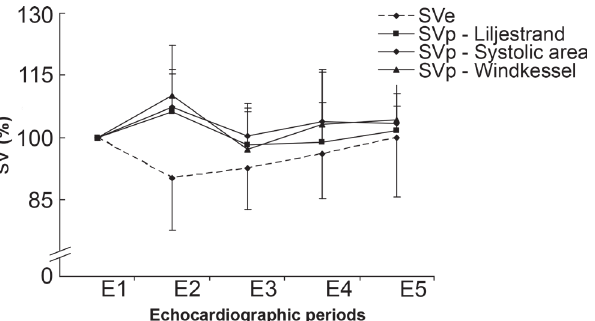
Fig 3. Stroke volume (SV) computed from echocardiographic and finger arterial blood pressure recordings (SVe and SVp respectively), at the time points described in Fig. 1. Three algorithms were used for SVp computation: Liljestrand, the systolic area and Windkessel.